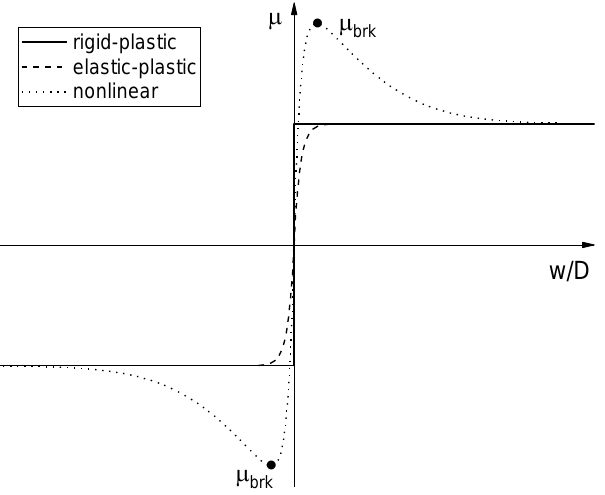
Figure 3. Pipe – soil interaction models.